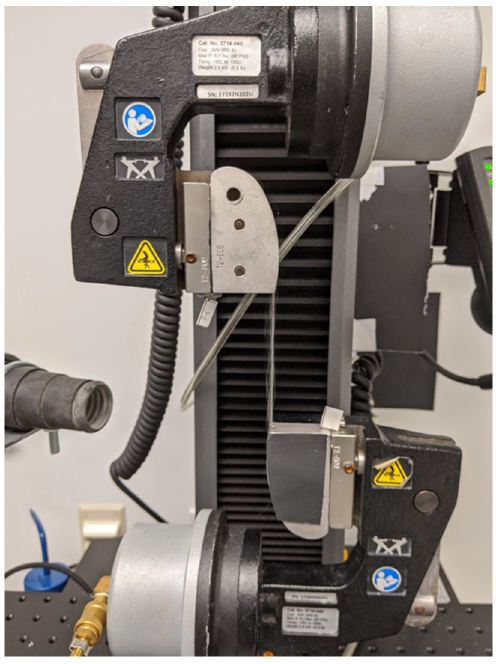
Figure 6. Yarn tensile testing experimental setup